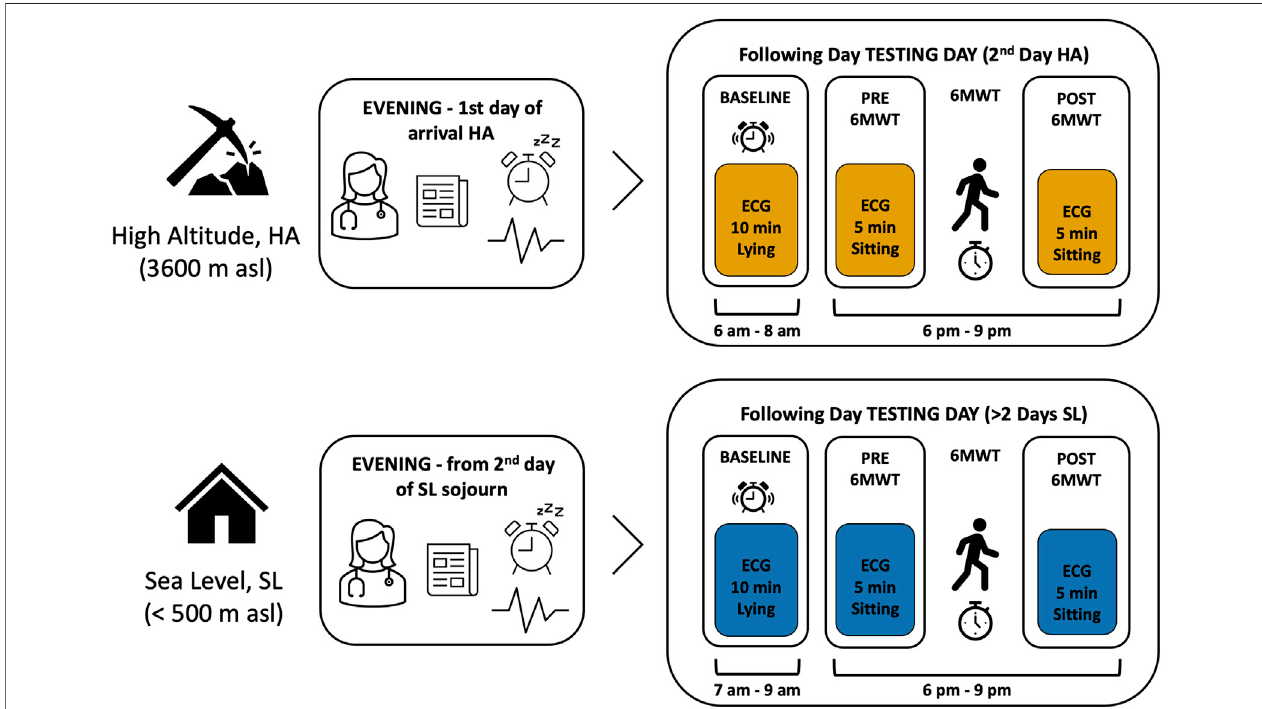
FIGURE 2 | Experimental protocol overview. Schematic description of experimental protocol. Measures at SL and HA were performed in a random sequence. On theeveningoftheirarrivalinHA(boxestotheright)participantswereinstructedbytheresearcher(pictogramdoctor)ontheuseofthewearabledeviceformeasuringthe electrocardiography (i.e., ECG, pictogram line as ECG wave) and were informed on the recording constraints. They also signed the informed consent (pictogram document) and were asked to note the time of awakening in the following morning (pictogram alarm clock). Once instrumented with the ECG sensor, the continuousmonitoringwasstartedandtheywereaskedtogotosleep.Duringthefollowingday(testingday),fromthecontinuousECGrecording,speci fi ctimewindows wereselectedfordataanalysis:inthemorning,uponawakening,atimewindowof10min(Baseline)andtwotimewindowsof5mineach,before(PRE) andafter(POST) the 6-minute walking test (6MWT), see boxes to the